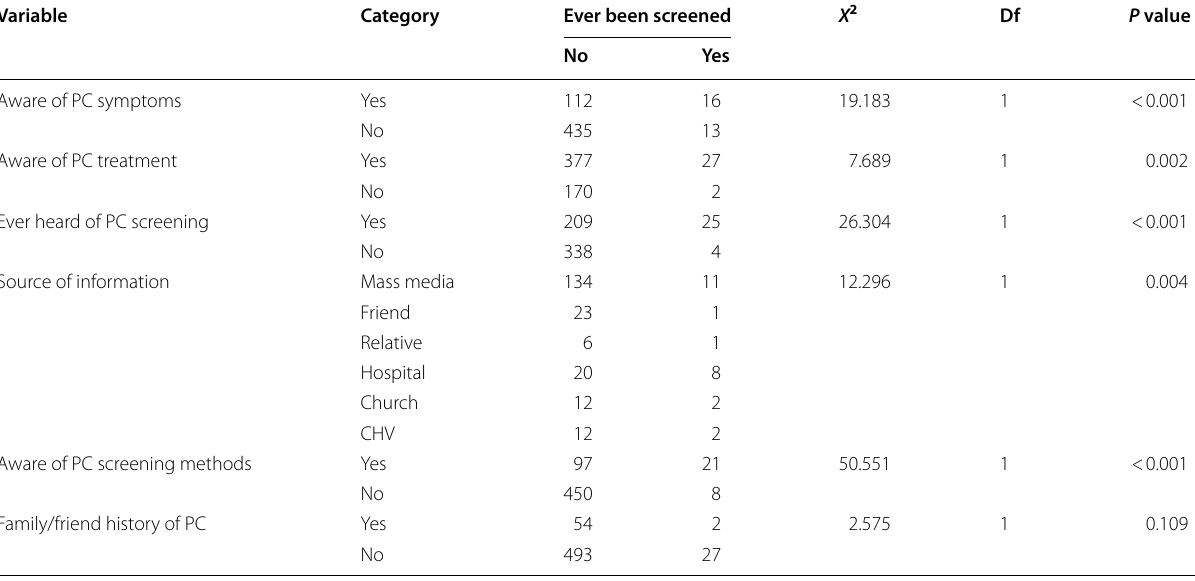
PC Prostate cancer; CHV Community Health Volunteer Table 5 Logistics regression analysis of awareness and prostate cancer screening